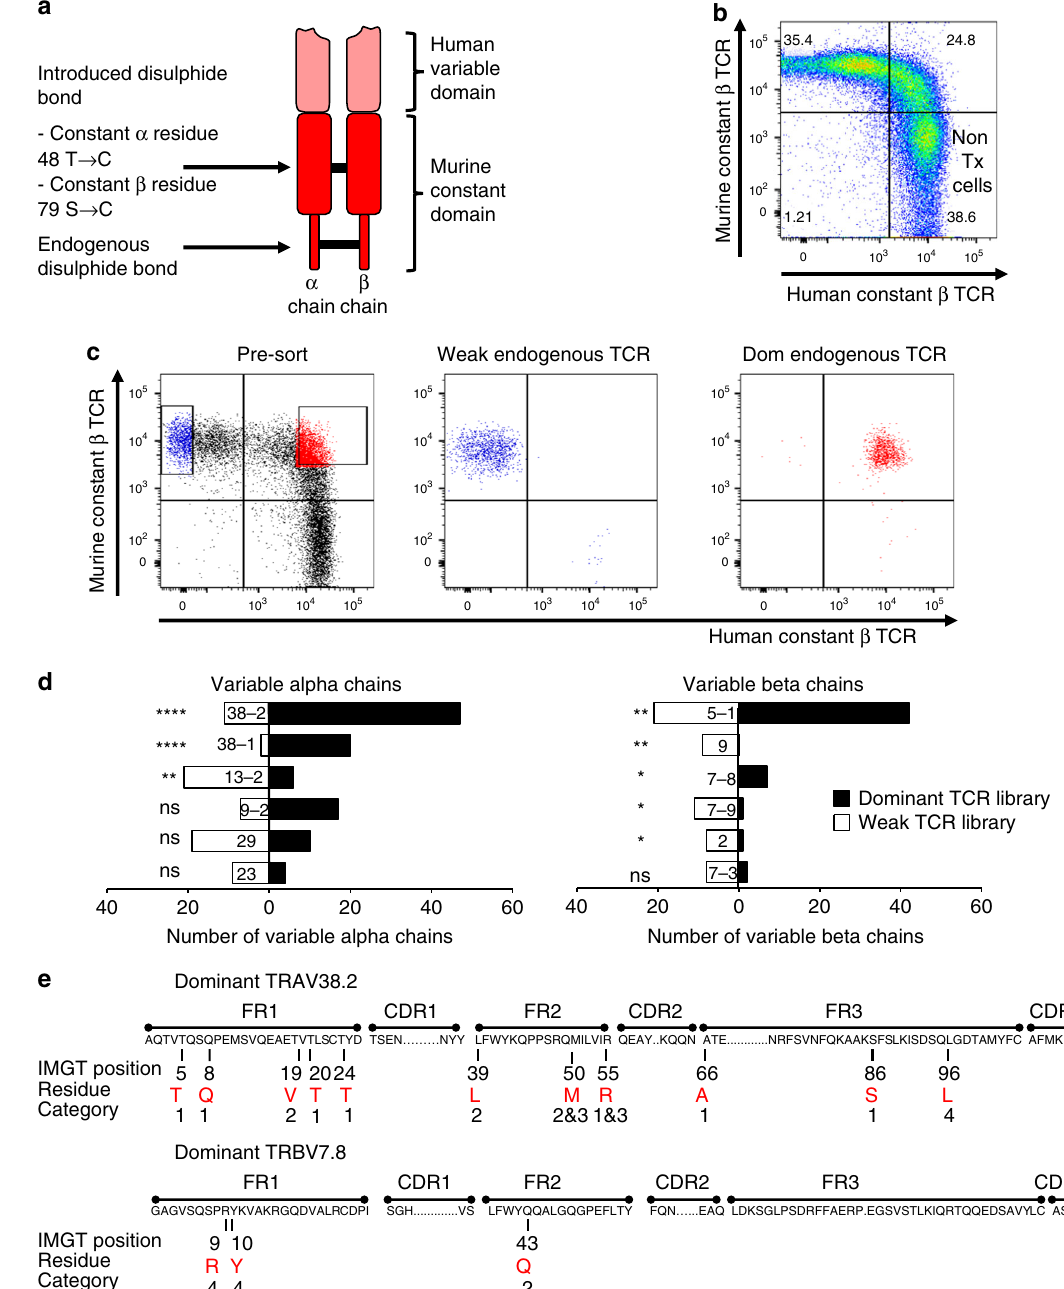
Fig. 1 Identi fi cation of dominant and weak human TCRs. a Schematic representation of a synthetic dominant TCR containing codon-optimized human variable domains and codon-optimized murine constant domains with an additional disul fi de bond (C48 α and C79 β ; IMGT nomenclature). b Dot plot of polyclonal peripheral blood human T cells transduced with a synthetic dominant TCR speci fi c for WT1 and double-stained with anti-human constant domain antibodies to identify the endogenous TCR and anti-murine constant domain antibodies to identify the introduced TCR. Live, single cells were fi rst gated on CD3. Non-transduced (non-Tx) T cells are labeled. c Transduced T cells expressing weak endogenous TCRs and transduced T cells expressing dominant endogenous TCRs were puri fi ed by fl ow cytometry. An unbiased molecular approach was then used to identify all expressed TCRs. The experiment was repeated independently with n = 3 different donors, and the TCR-sequencing data were pooled. d T cells receptor variable gene segment frequencies in the library of dominant TCRs (solid black bars) and the library of weak TCRs (open bars). * P < 0.05; ** P < 0.01; **** P < 0.0001; ns, P > 0.05 (unpaired t -test). e Candidate residues in the framework regions of the V α and V β domains that were selected for detailed studies based on structural analyses and occurrence at high frequencies in the dominant TCR library. Candidate residues are shown in red letters. Numbers above the residues denote the IMGT positions. The category numbers indicate the position of residues in the TCR structure. 1. Solvent exposed; 2. hydrophobic core; 3. V α – V β interface; 4. V α – C α or V β – C β interface. FR framework region, CDR complementarity-determining